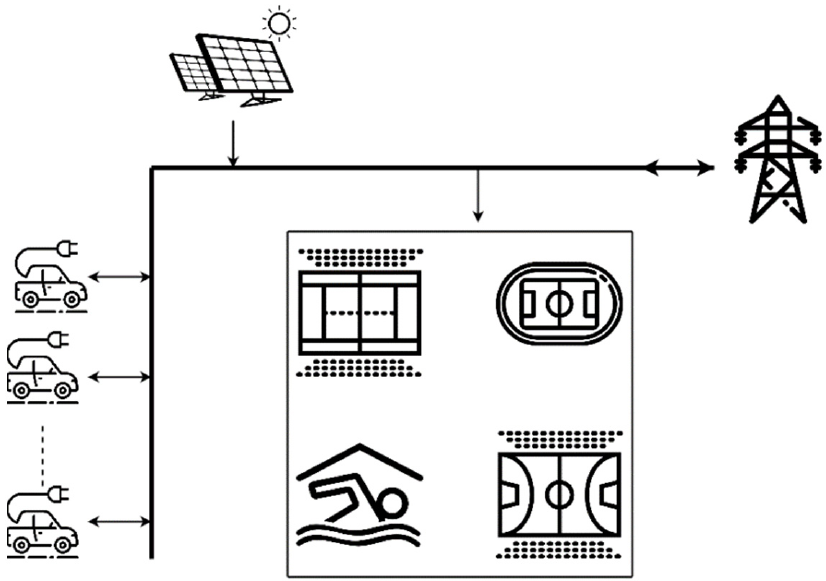
Figure 9. Microgrid layout.